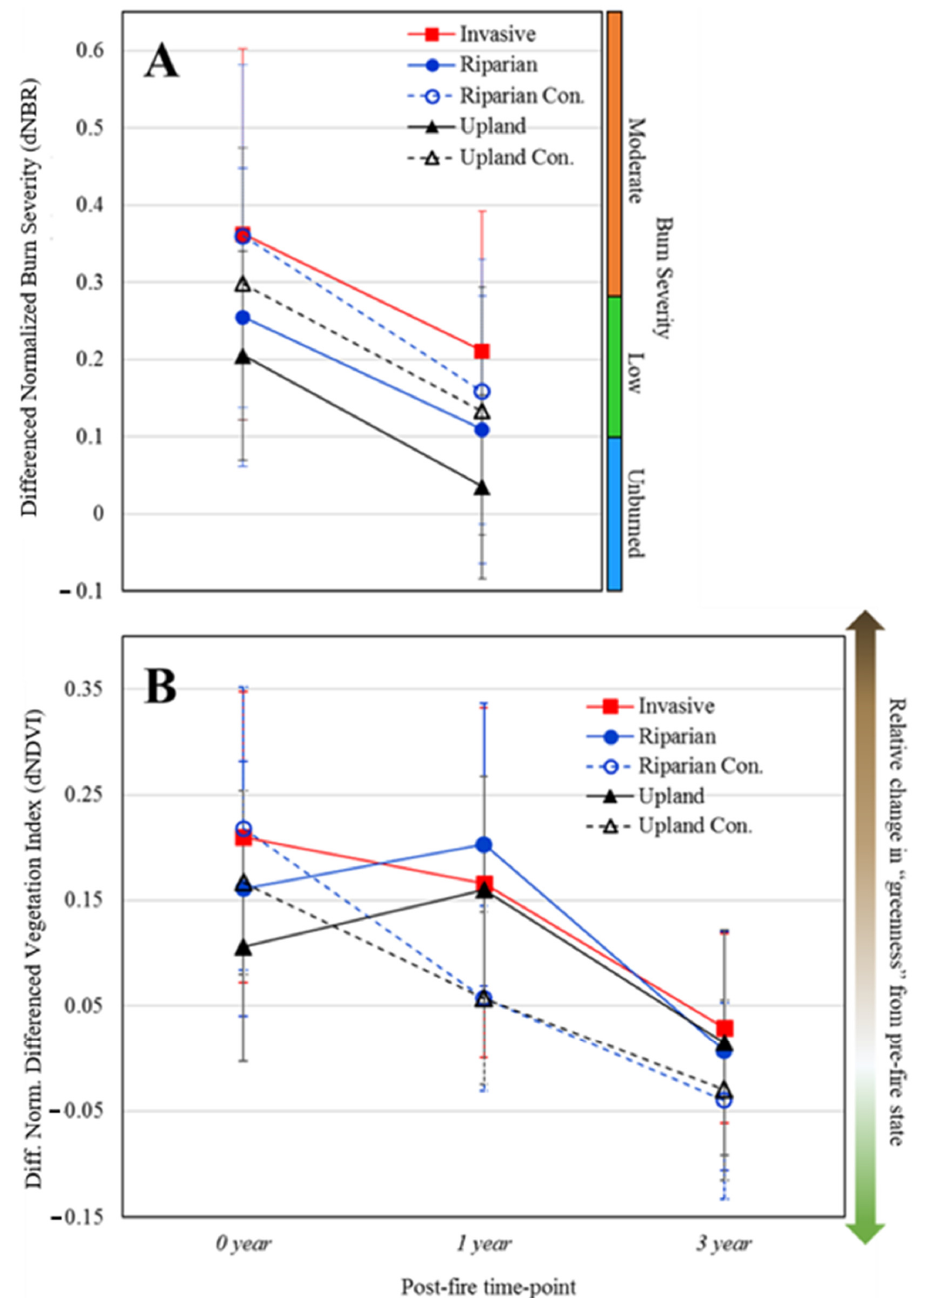
图 3 Figure 3. Average dNBR and burn severity across all fires by vegetation class for 0-year post-fire and 1-year post-fire ( A ). Burn severity is categorized by dNBR. Average dNDVI and relative change in “greenness” for invasive and control fires by vegetation class for 0- year post-fire, 1-year post-fire, and 3-year post-fire ( B ). Positive values above zero indicate a loss of greenness, and negative values indicate an increase in greenness. One year following the fire, the largest green canopy recovery occurred for control fires, where the upland control class decreased by − 66%, and the riparian control decreased by − 74%. After 1-year, the average dNDVI for the upland and riparian classes in control fires converged and remained statistically similar to each other through the 3-year. The lowest recovery in green canopy 1-year post-fire occurred in the riparian class, where the 1-year dNDVI value (0.203 ± 0.133) was 27% higher than the 0-year value. The upland followed a similar pattern to the riparian but exhibited an even larger relative loss of